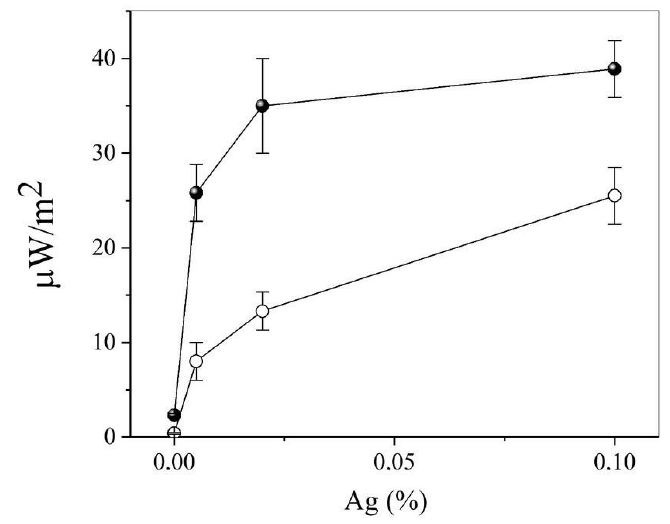
Figure 4. Dependence of the thermal radio emission flux density on the concentration of silver proteinate nanoparticles (the drug concentration is indicated in terms of elemental silver) in a 1 mm layer of paraffin at t = 23 °C (white circles) and t = 37 °C (dark circles–balls).